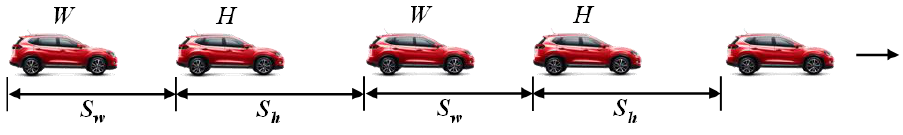
Figure 5. Schematic diagram of mixed traffic vehicle following.